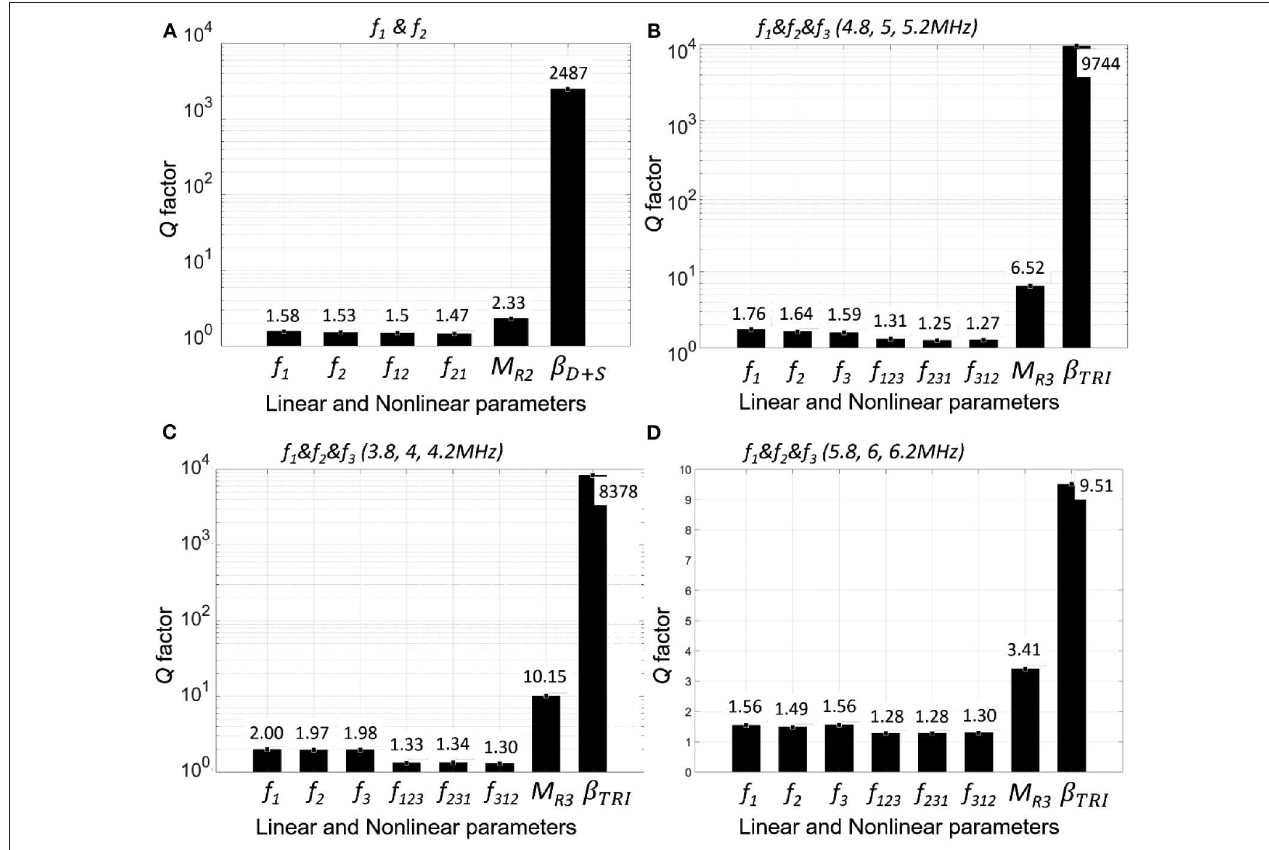
FIGURE 12 | SFC sample comparison of SNR at damage region/notch for dual frequency modulation (A) and tri frequency modulation: (A) dual frequency modulation (4.8 & 5.3 MHz); (B) tri frequency modulation (4.8 & 5 & 5.2 MHz); (C) tri frequency modulation (3.8 & 4 & 4.2 MHz); (D) tri frequency modulation (5.8 & 6 & 6.2 MHz).